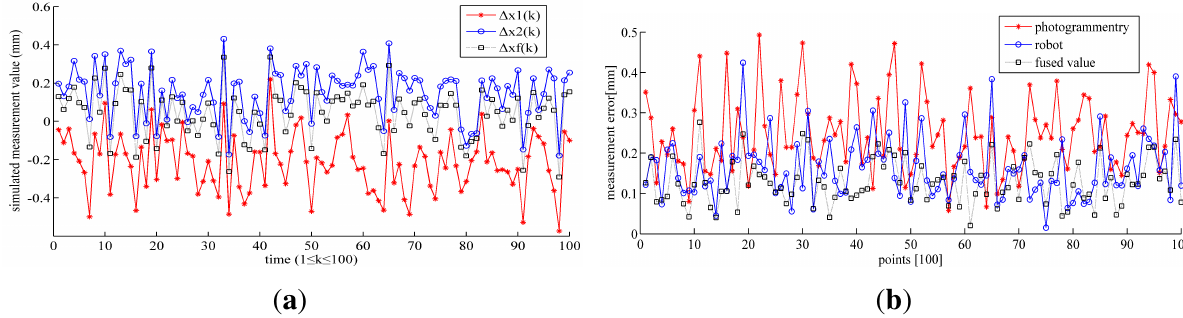
Figure 7. ( a ) The simulated fused error using the KF method; ( b ) The simulated fused error using the multi-sensor optimal information fusion algorithm (MOIFA).